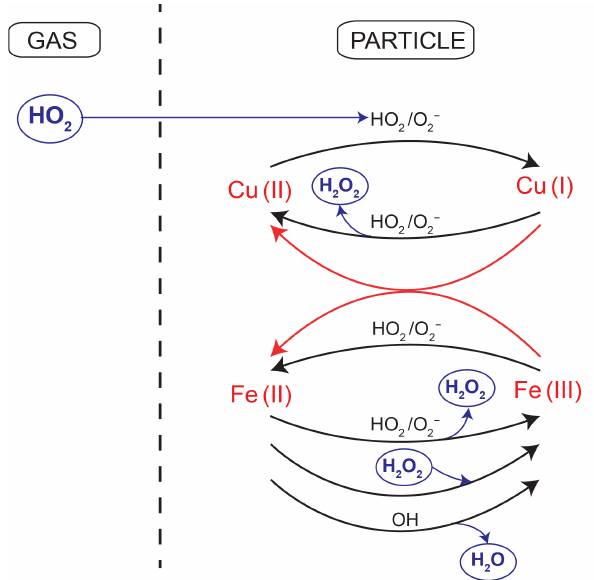
Fig. 1. Cu-Fe redox coupling in aqueous aerosols driven by HO 2 uptake from the gas phase. In the presence of dissolved Cu alone, HO 2 is converted to H 2 O 2 . In the presence of both dissolved Cu and Fe, HO 2 is converted to either H 2 O 2 or H 2 O and may also catalytically consume H 2 O 2